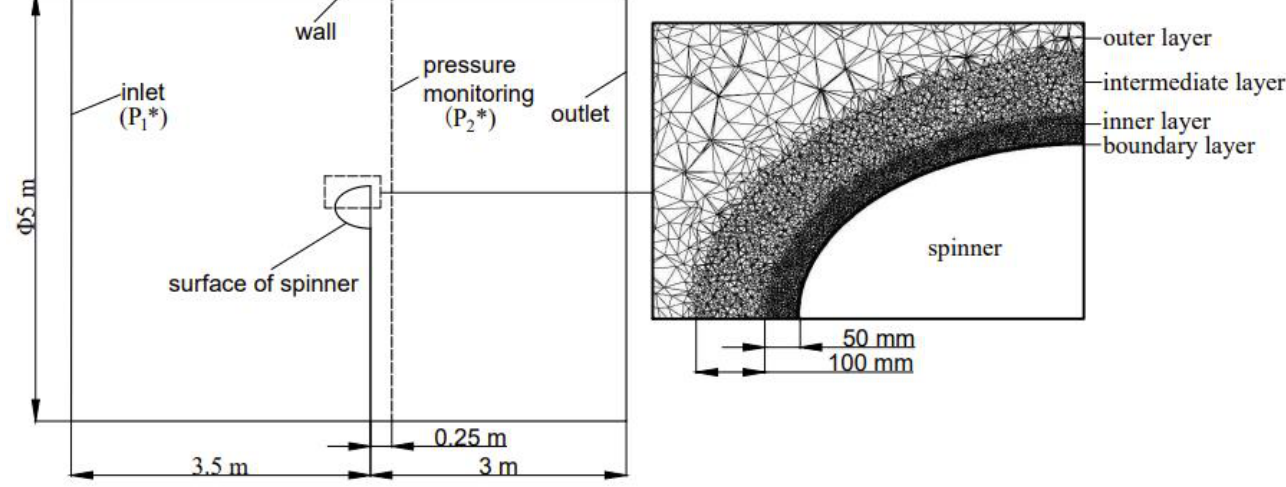
Figure 3. Schematic of mesh division with four mesh